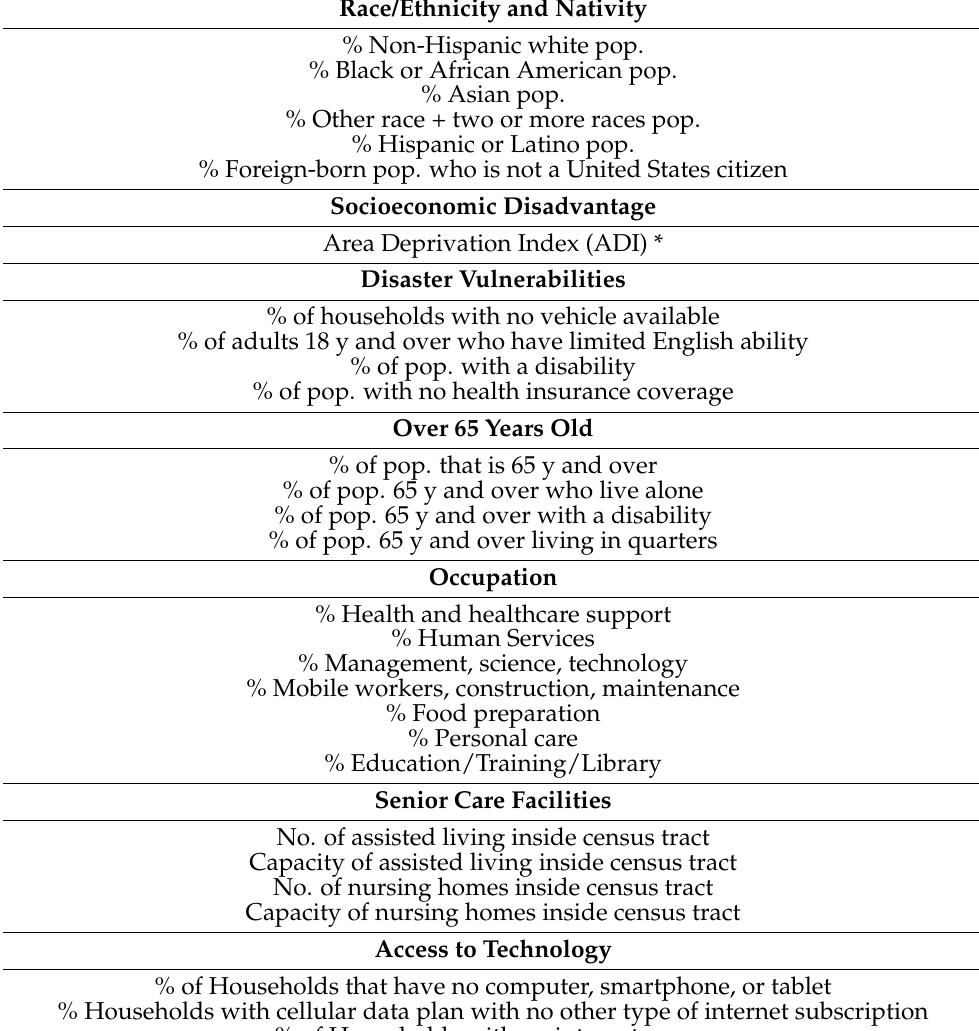
Table 1. List of Independent